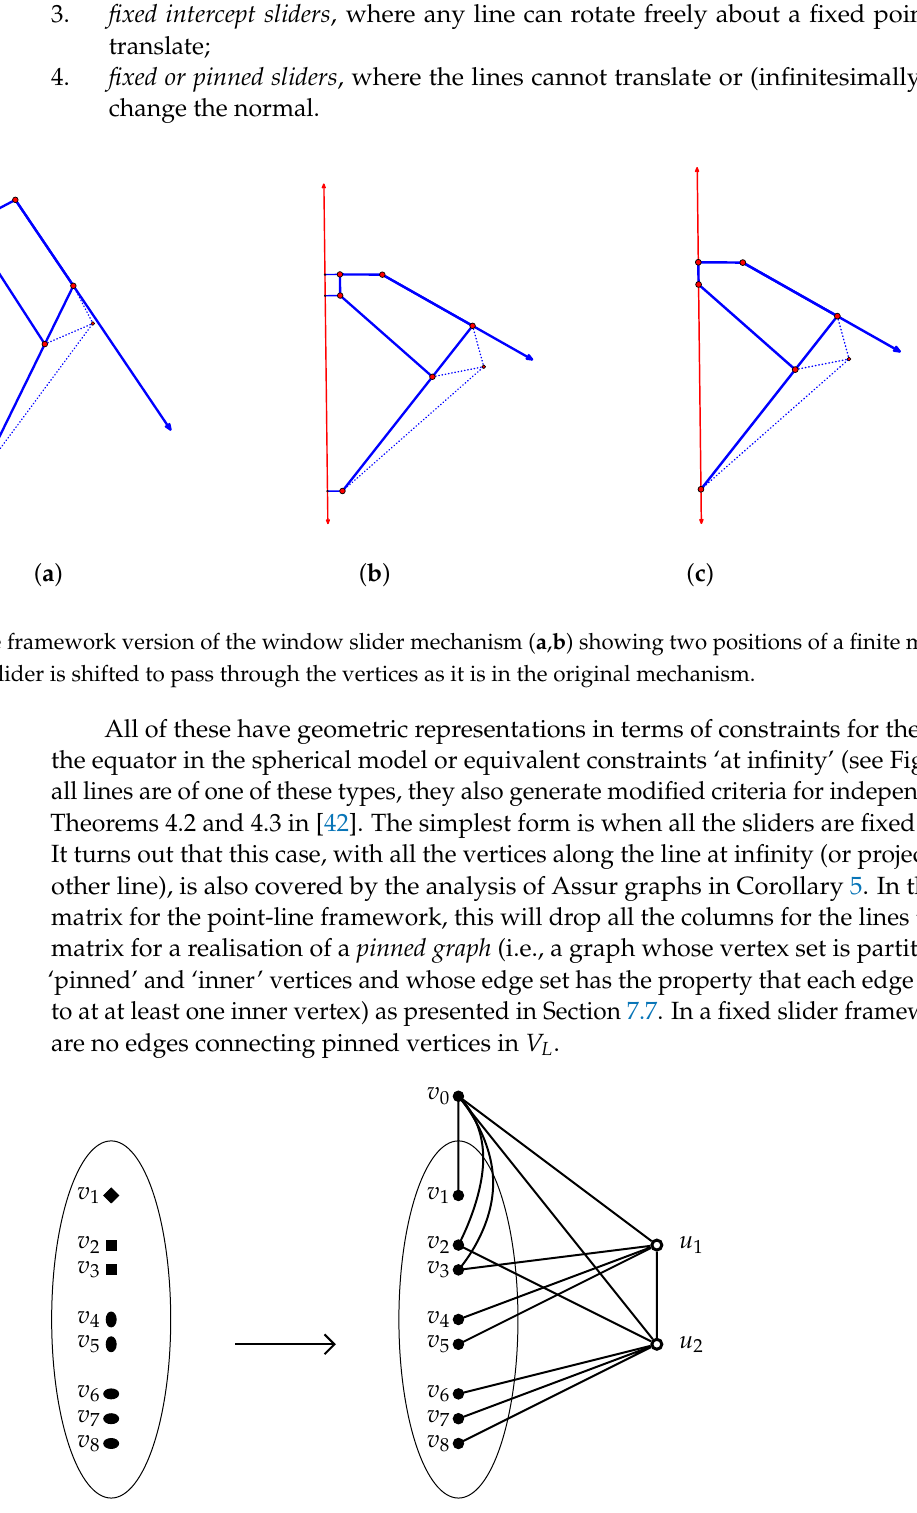
v 4 , v 5 have a fixed center of rotation and { }